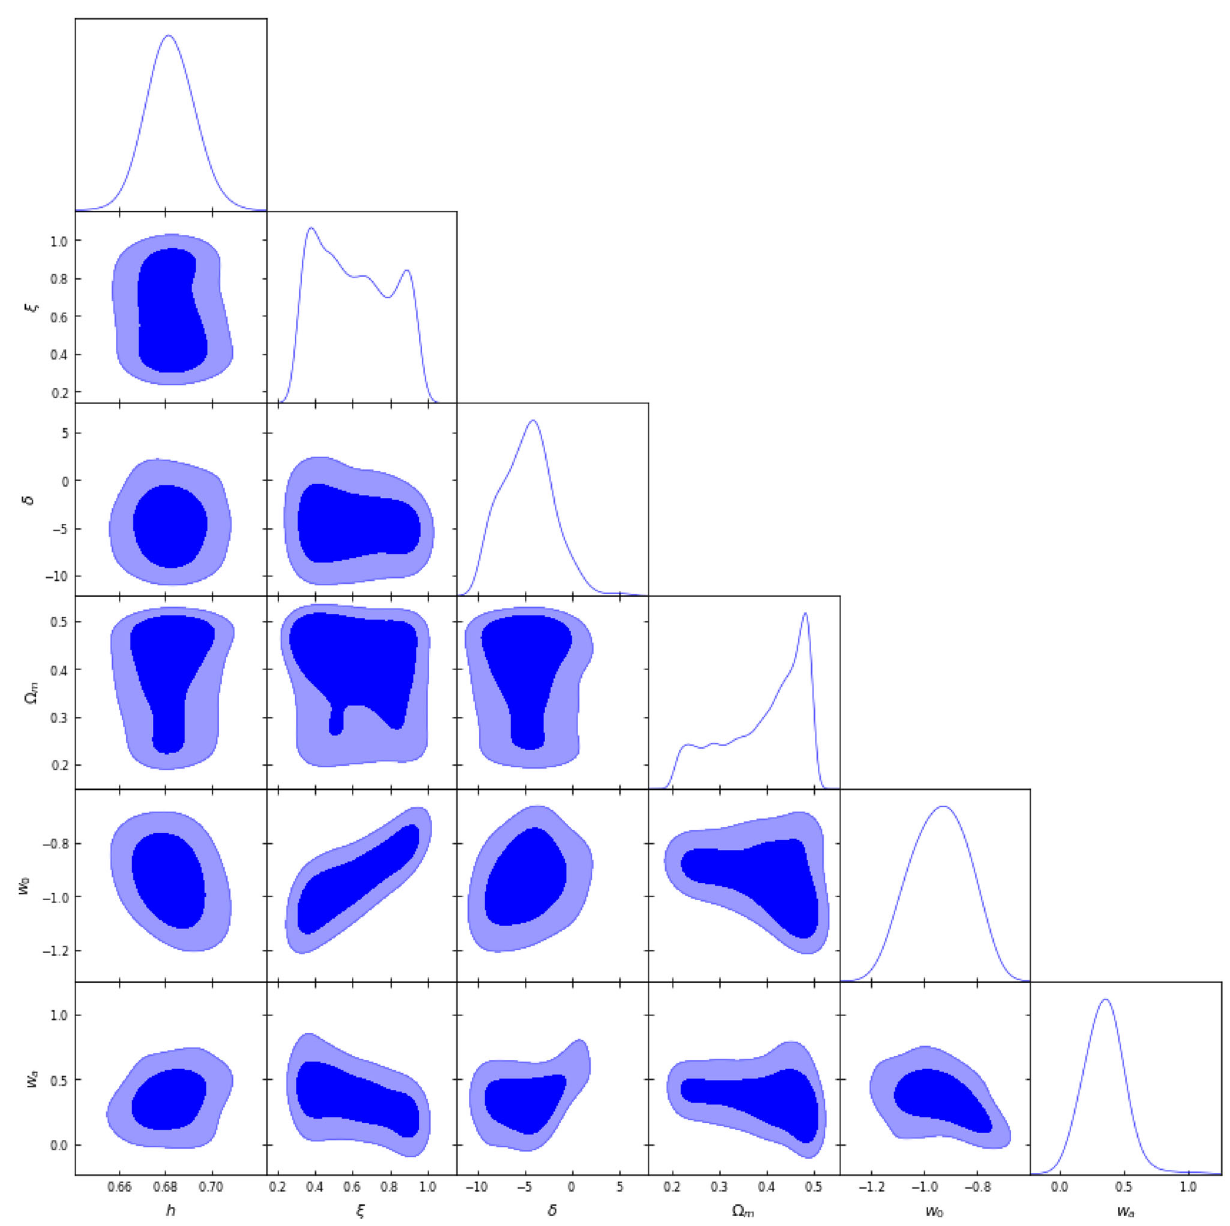
Fig. 1 Here we show the results for the posterior 1D and 2D of the model (19) using both H ( z ) measurements and supernovae